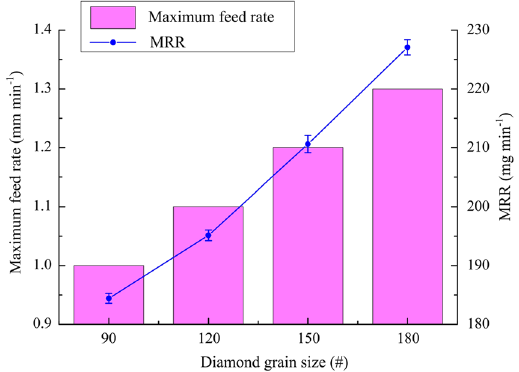
Figure 7. Variations of maximum feed rate and MRR with diamond grain size.